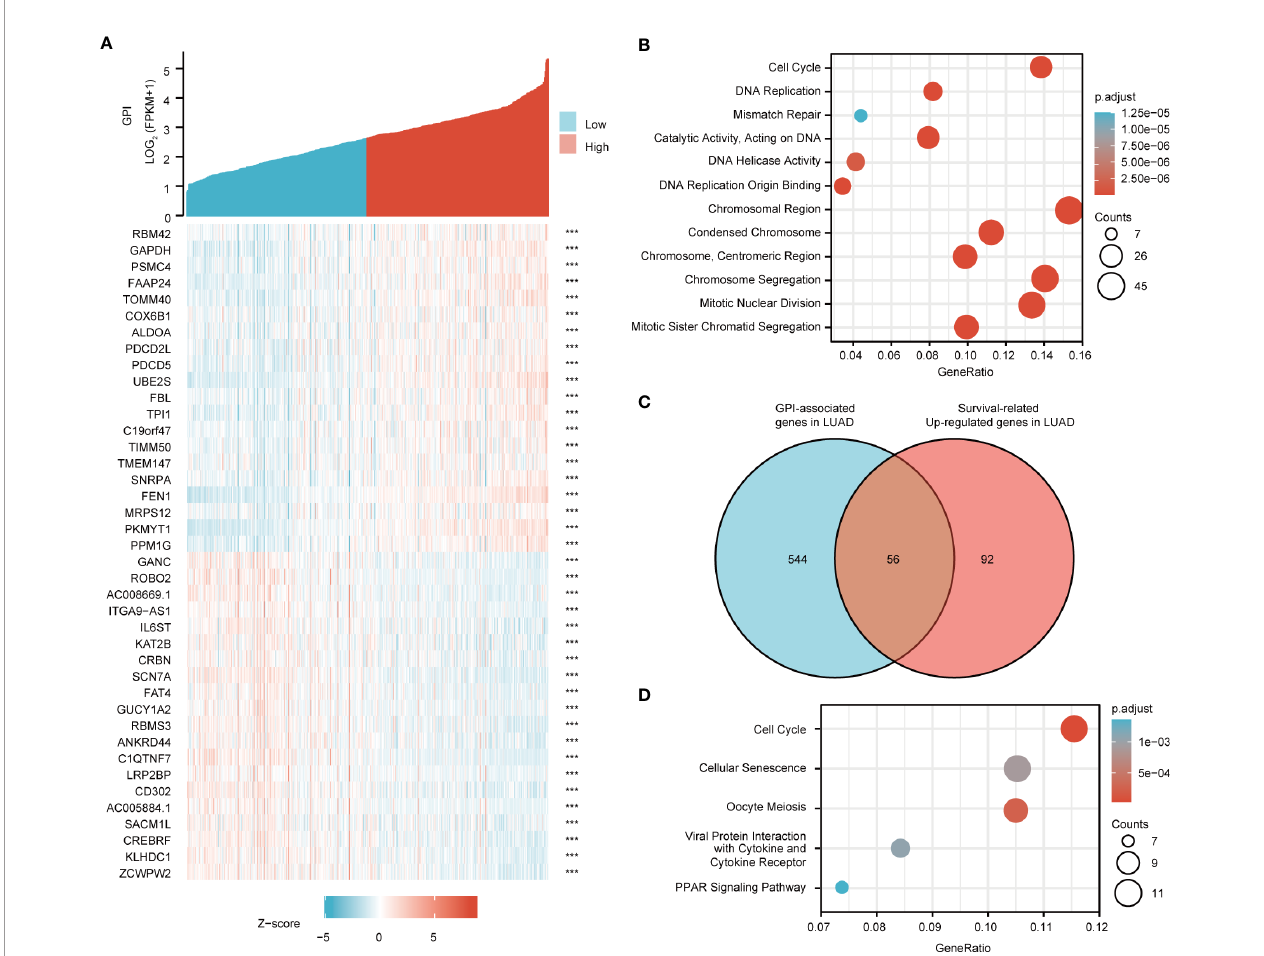
FIGURE 7 | Glucose-6-phosphate isomerase (GPI) functional clustering and interaction network analysis of GPI-related genes. (A) Heatmap showing the top 50 genes in lung adenocarcinoma (LUAD) that were positively and negatively related to GPI. Red represents positively related genes and blue represents negatively related genes. (B) Gene Ontology (GO) term and Kyoto Encyclopedia of Genes and Genomes (KEGG) pathway analyses of GPI-related genes in LUAD. (C) Venn diagram of the GPI-related genes and the survival-related and upregulated genes in LUAD. (D) GO term and KEGG pathway analyses of the GPI-related genes and LUAD survival-related genes in